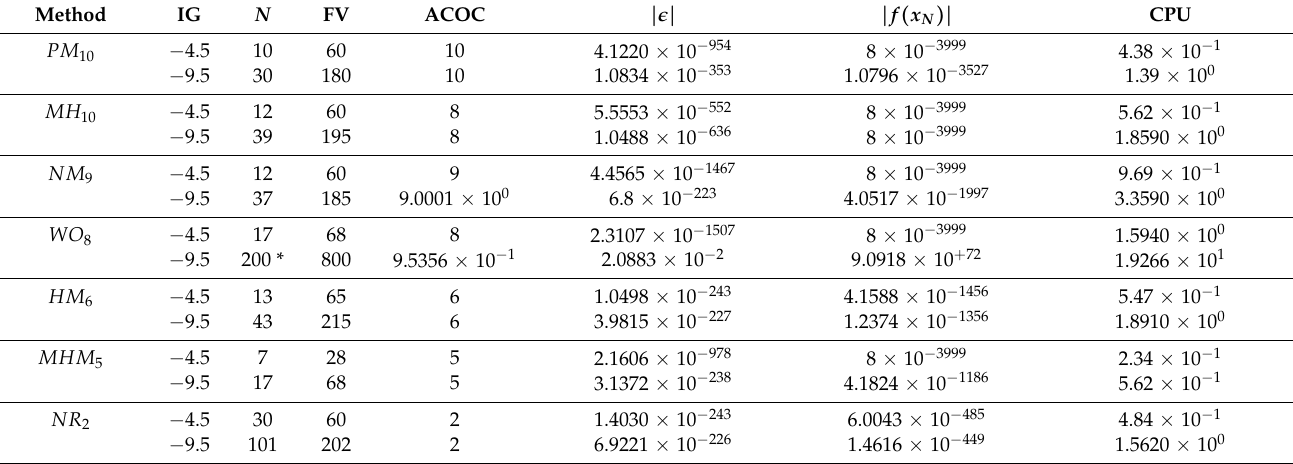
Table 6. Numerical results for problem 2: g 4 ( x ) with ∗ showing the divergence of the